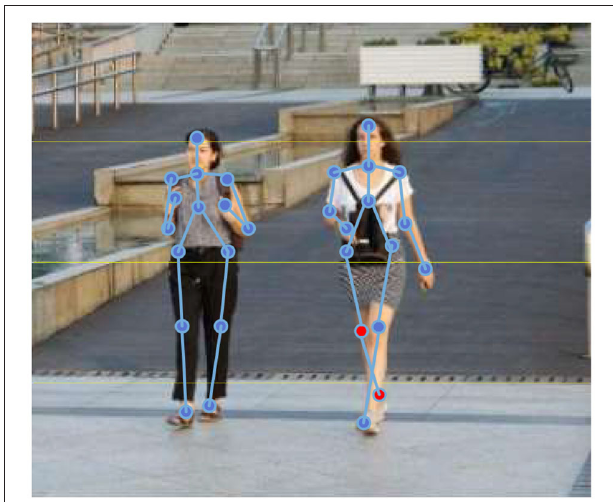
FIGURE 5 | The joint points recognition of the 3D motion in the JTA dataset.